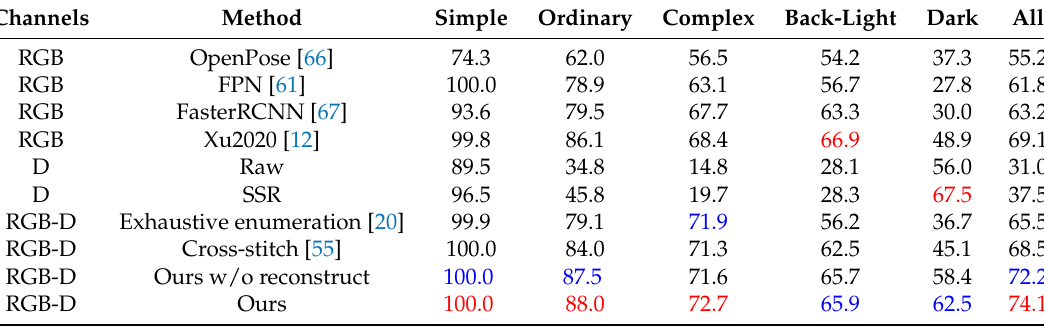
Table 2. Detection AP of the compared methods. The first column indicates the channels used for detection: “RGB” denotes RGB image based methods, “D” denotes depth image based methods, and “RGB-D” denotes RGB-D fusion based methods. The columns “Simple”, “Ordinary”, “Complex”, “Back-light” and “Dark” denote the five testing cases explained in the main text, and the column “All” denotes the overall test including all the cases. The red color denotes the best scores, and the blue color are the second best scores.